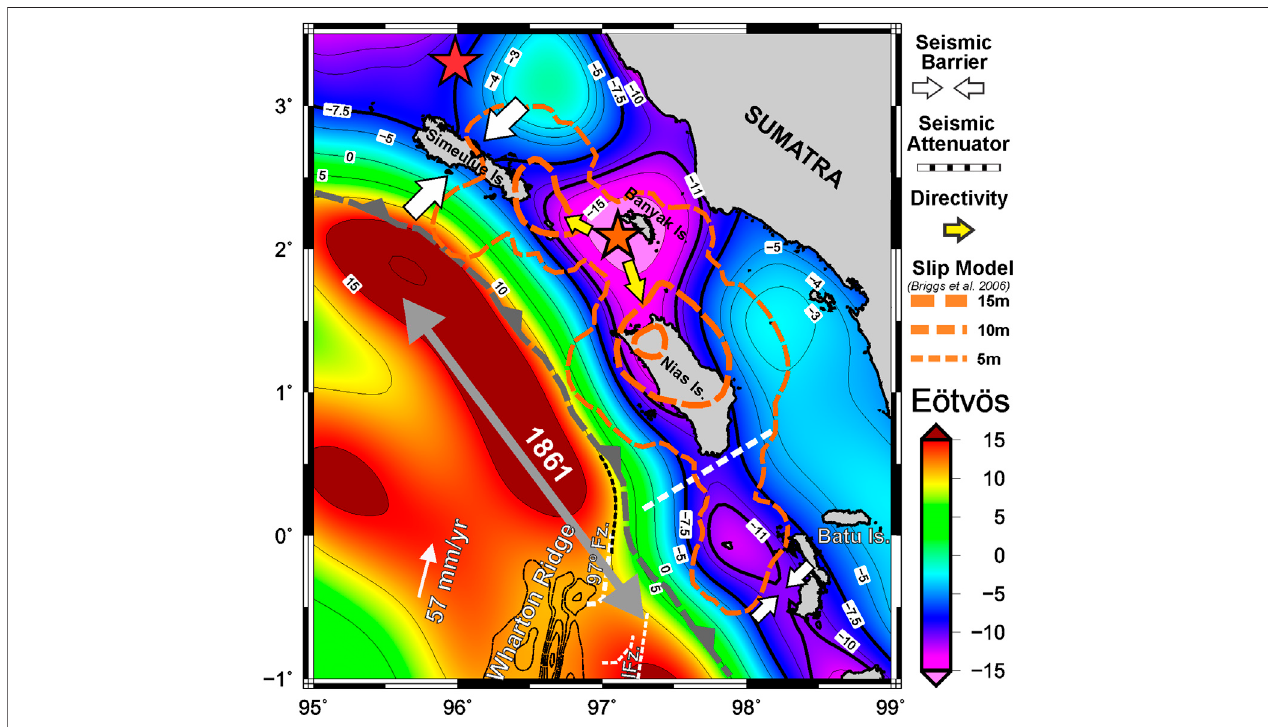
FIGURE6| Slipmodel(dashedorangecontours)fortheMw (cid:1) 8.62005Simeulue-Niasearthquake(Briggsetal.,2006)superimposedtothetopographycorrected verticalgravitygradient(Tzz)obtainedfromGOCEmodelGO_CONS_GCF_2_DIR_R6uptoN (cid:1) 200(Bruinsmaetal.,2014).Thedashedwhitelineindicatesthelocation of regions that behaved as seismic energy attenuators; white arrows indicate the existence of a seismic barrier that arrested rupture propagation. The great historical earthquake of 1861 is indicated with gray double-arrows (Newcomb and McCann, 1987).